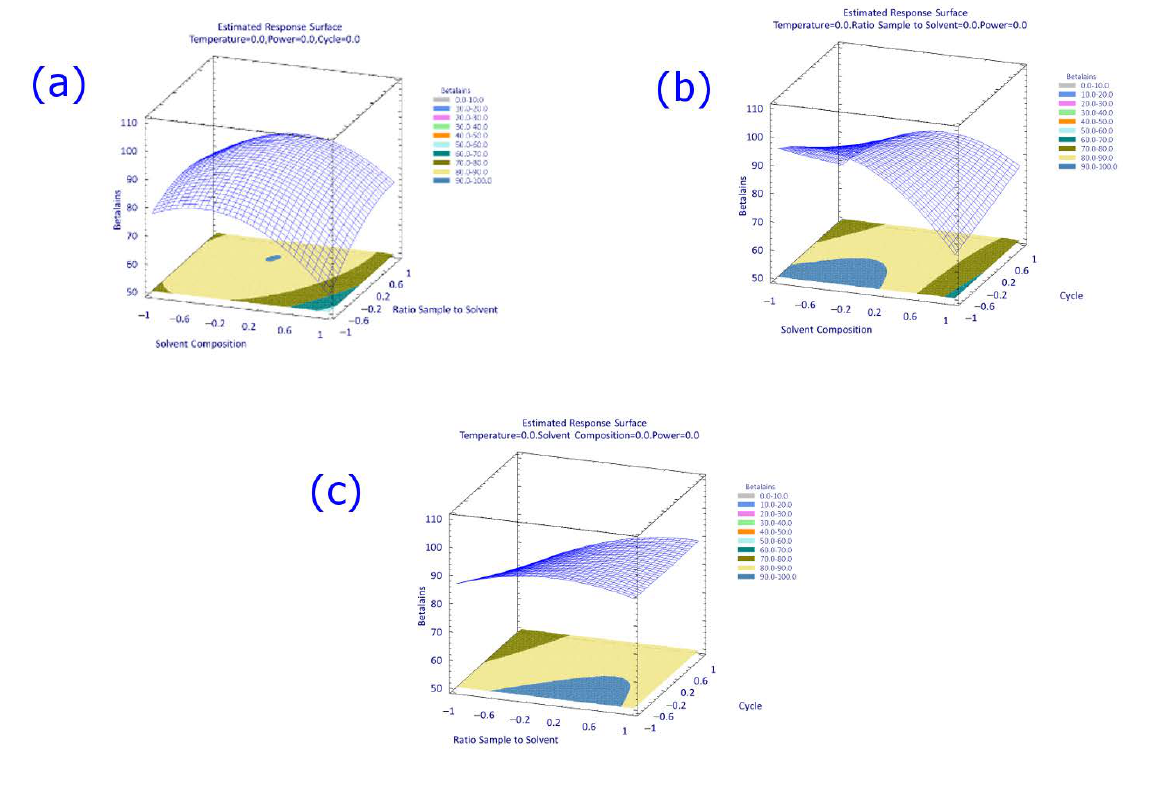
Figure 3. Response surface graphs according to the significant independent variables: ( a ) solvent composition (B) vs. sample-to-solvent ratio (C); ( b ) solvent composition (B) vs. cycle (E); ( c ) sample-to-solvent ratio (C) vs. cycle (E), since they are the most significant variables regarding extraction